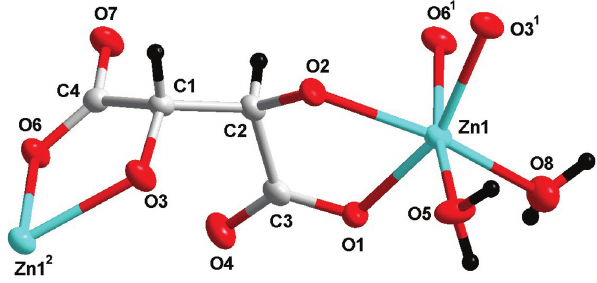
Table 1: Data collection and handling.